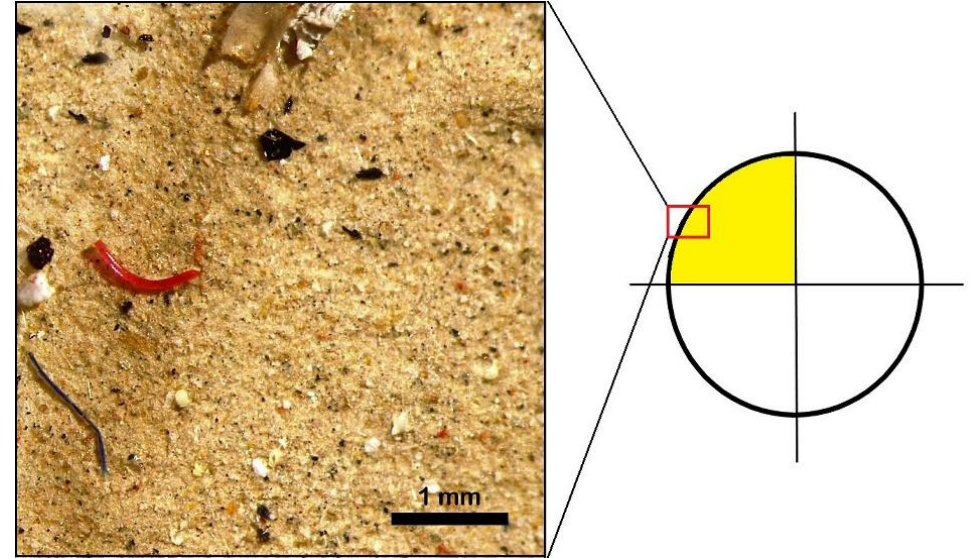
Figure 2. Example of MP* (red and black fibers) identified during binocular observations in the sediment sample and its position in the quarter of filter investigated (yellow area).